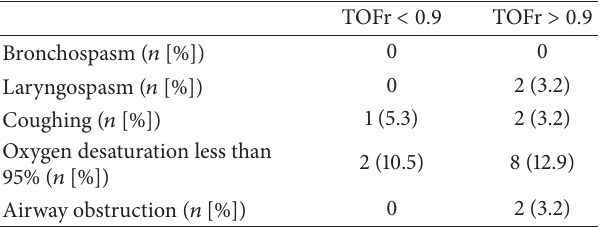
Table 2: Incidence (%) of adverse events in the recovery room in patients with (train-of-four [TOF] ratio < 0.9) versus without (train-of-four [TOF] ratio > 0.9) residual neuromuscular blockade. All differences were found to be not